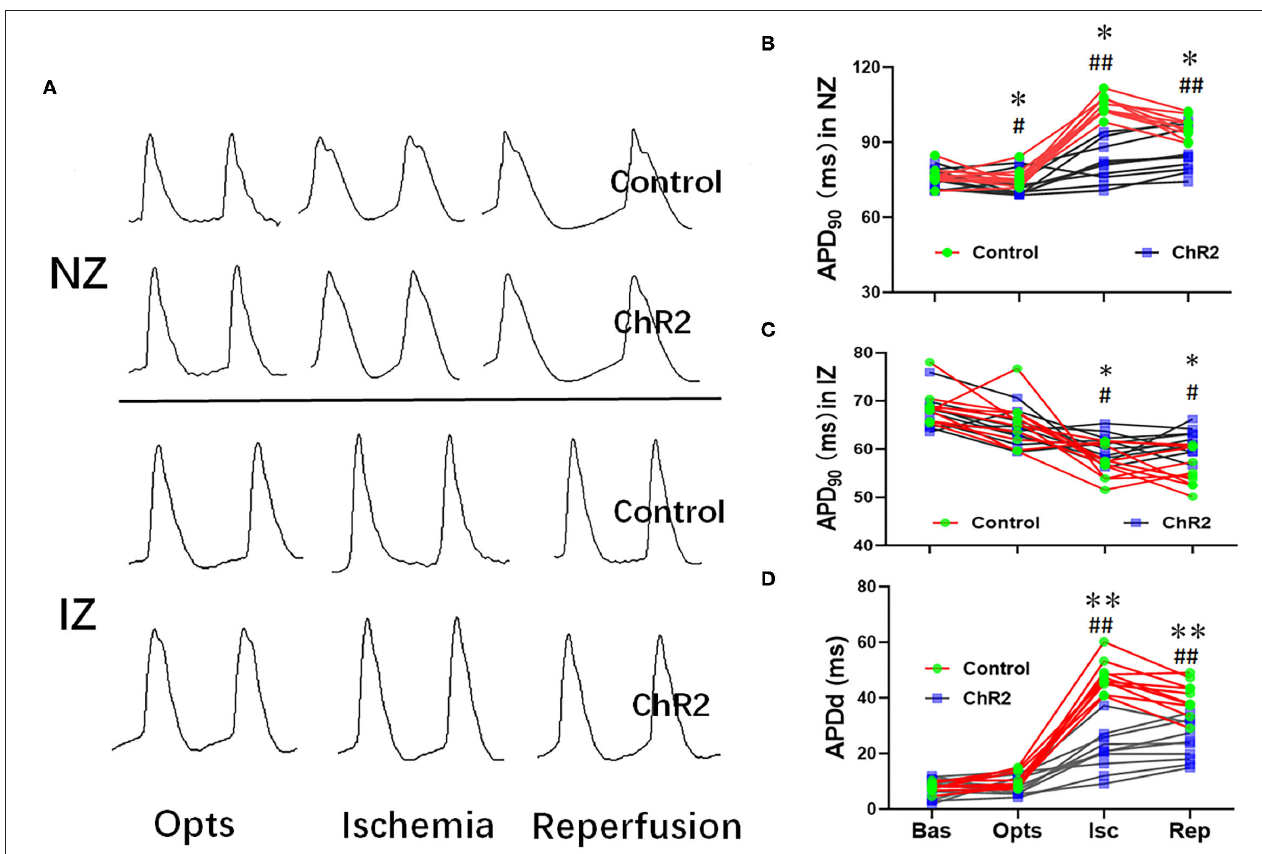
FIGURE 3 | Selective optical stimulation of the dorsal horn prevents cardiac APD abnormalities during myocardial ischemia-reperfusion. Representative traces of monophasic action potentials (MAPs) both none-infarcted zone (NZ) and infarcted zone (IZ) during 15min of ischemia and 30min of reperfusion (A) . Quantitative analysis of APD 90 at baseline (Bas), optical stimulation (Opts), ischemia (Isc), and reperfusion (Rep) from NZ (B) and IZ (C) . (D) Optical stimulation of ChR2 can significantly decrease APD dispersion during myocardial ischemia-reperfusion. Data are expressed as mean ± SD. A paired t -test was used to compare parameters before and after light stimulation and a t -test was used to compare differences between the ChR2 and control groups ( n = 10 per group; * P < 0.05, ** P < 0.01 vs. Control; # P < 0.05, ## P < 0.01 vs.